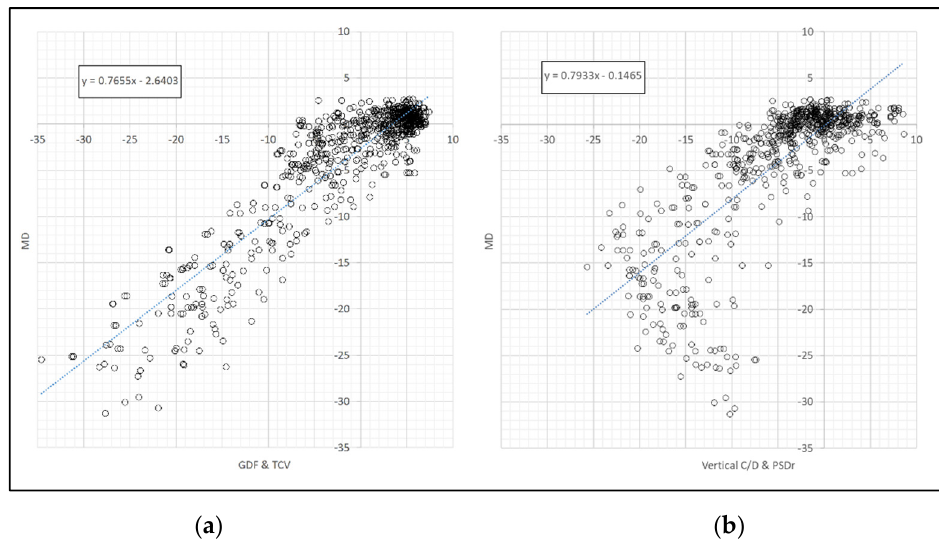
Figure 4. Relationship between the perimetric MD index and ( a ) the combined GDF and TCV and ( b ) the vertical C/D and PSDr (right) indices.